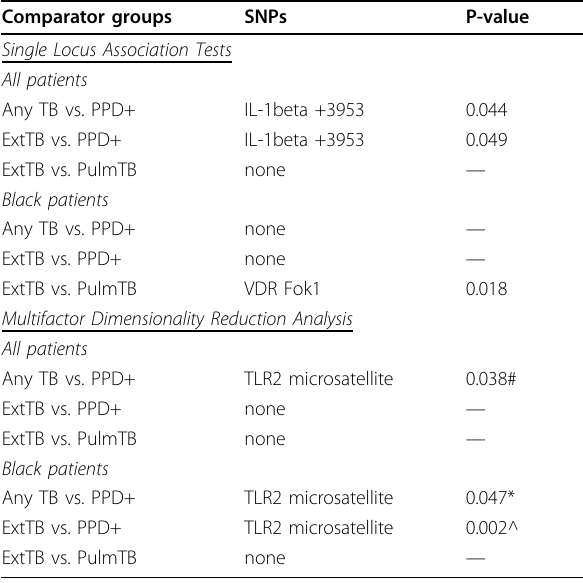
Table 3 Of the Polymorphisms Tested that had Previously Been Reported as Associated with Tuberculosis (Table 2), the SNPs Associated with Tuberculosis in this